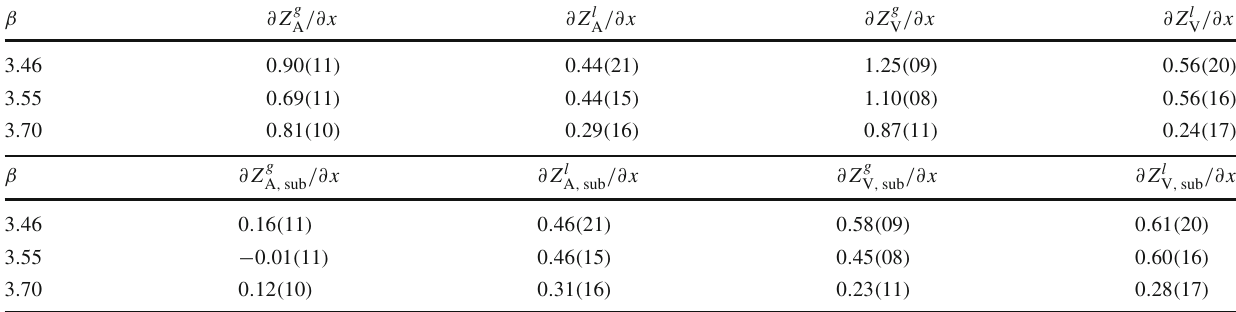
Table 13 Results for ∂ Z g from the linear fits using the 3 closest L / a -values to the target ( L 1 / a )(β)